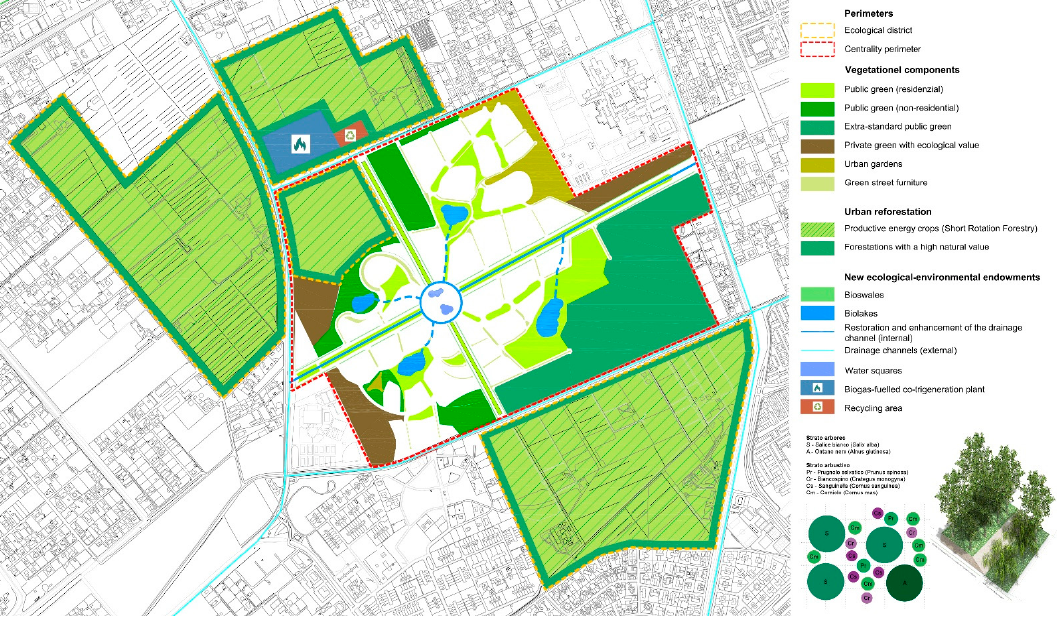
Figure 11. Rome Municipality X, Urban and Metropolitan Centrality Acilia–Madonnetta. Urban project. The green system and reforestation. (Source: elaborations by the students: S. Maiorano, F. J. Moran, A. Musto, C. Paloni, Urban Planning Laboratory of the Faculty of Architecture of Rome A.A. 2021–2022).